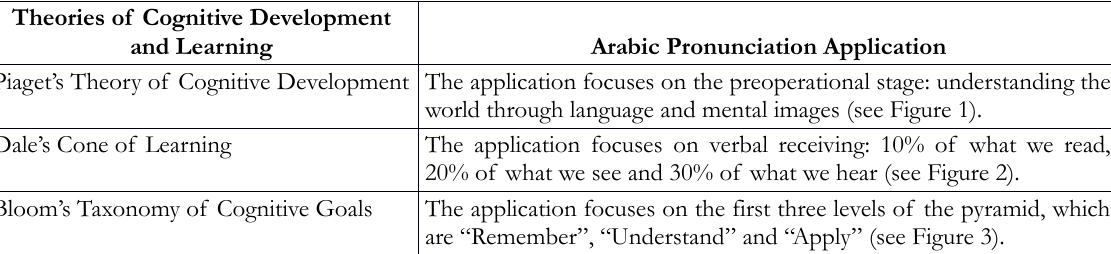
Table 1. similarities and differences between the theories and Arabic Pronunciation